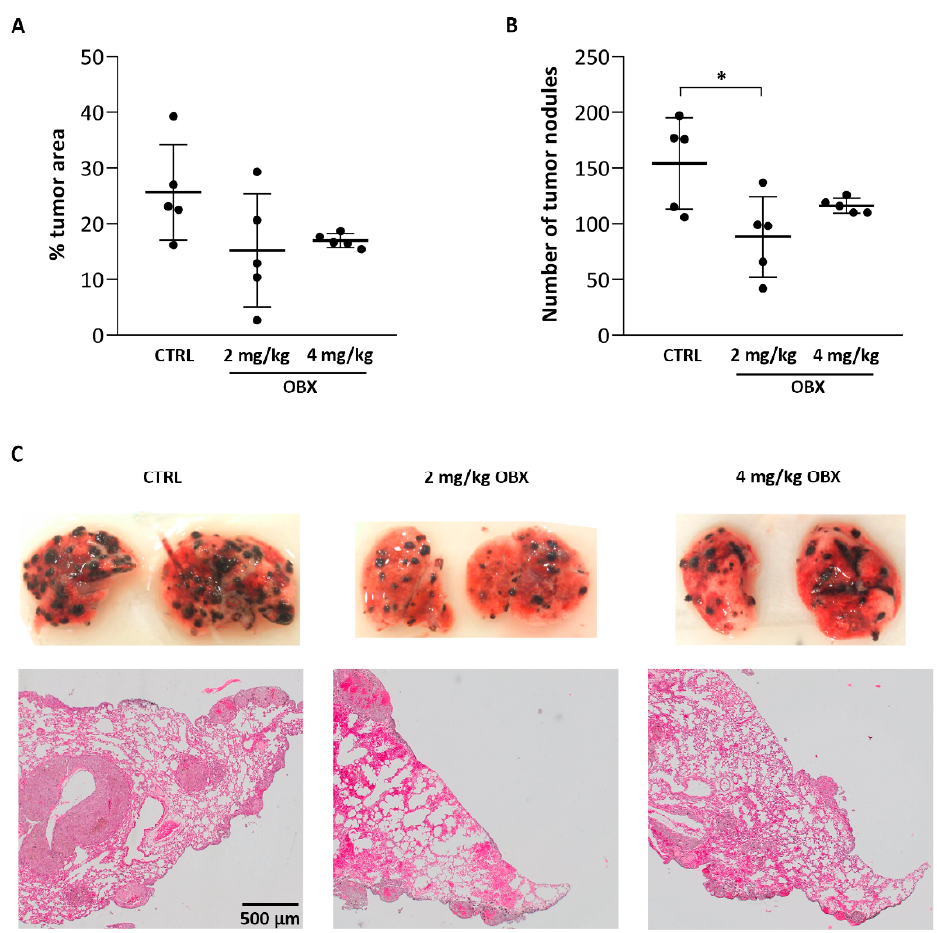
Figure 5. In vivo evaluation of antimetastatic properties of OBX. Mice with lung metastasis were treated daily with different doses of OBX (2 mg/Kg, 4 mg/Kg OBX) for 10 days. ( A ) Quantification of the tumor area in mice treated with OBX or vehicle (control, CTRL). ( B ) Quantification of the number of tumor nodules in control and treated mice. ( C ) Representative images of external photographs of the lungs and hematoxylin-eosin sections from lungs of control and treated mice. Statistical differences from control are shown as * p < 0.05.